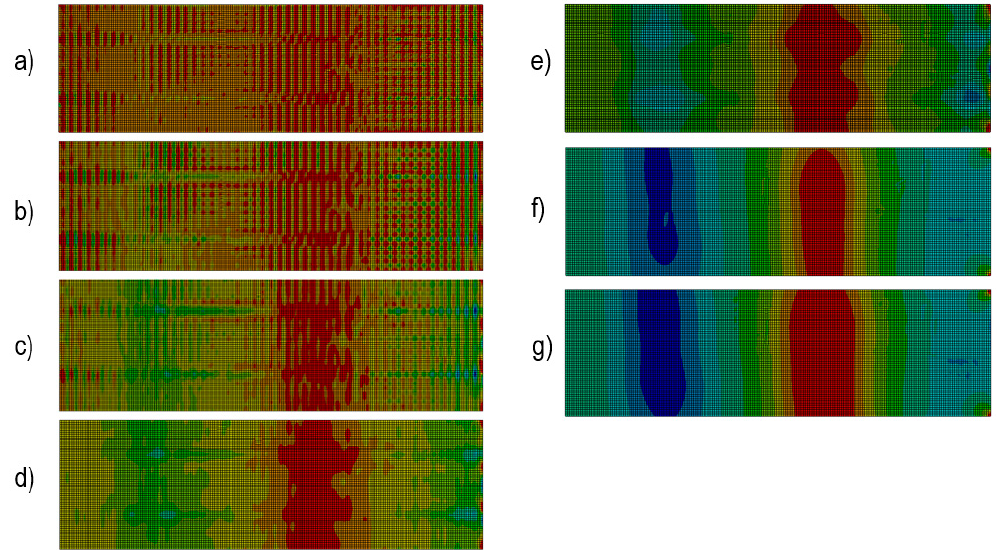
Figure 15. In-plane deformation test Step 1: HDPE membrane strain in the horizontal direction of ( a ) raw data and different cubic smoothing spline weighting parameter; ( b – g ) 10 − 1 , 10 − 2 , 10 − 3 , 10 − 4 , 10 − 5 , and 10 − 6 , respectively.